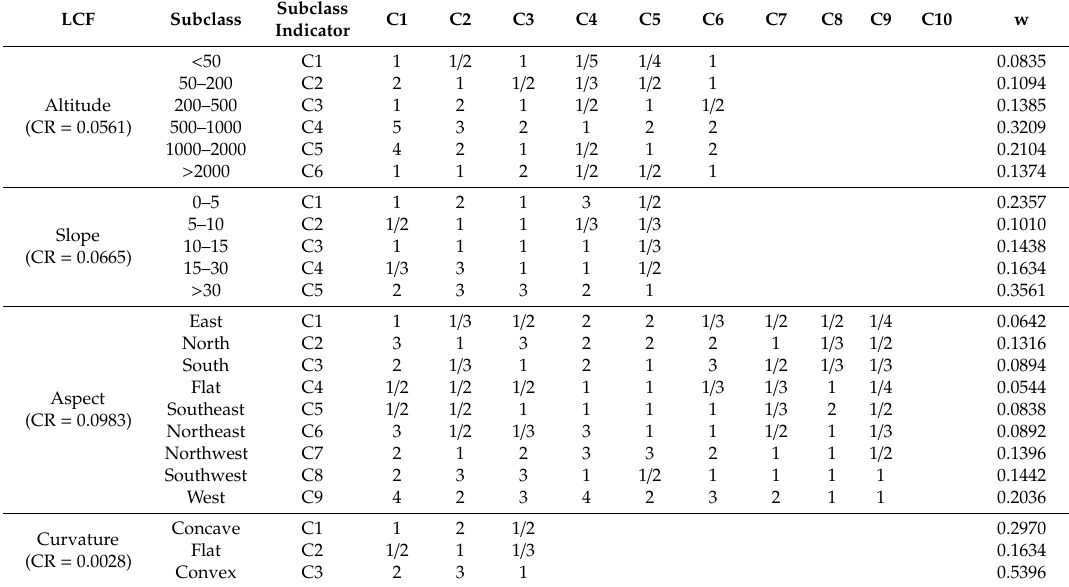
Table A2. Weights for subclasses within each LCF calculated using the conventional